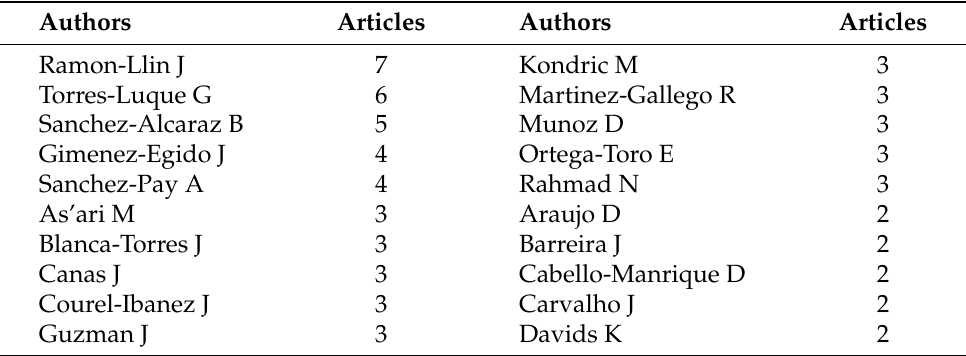
Figure 6. Cooperation on the basis of country and affiliations. Table 5. Top 20 most relevant